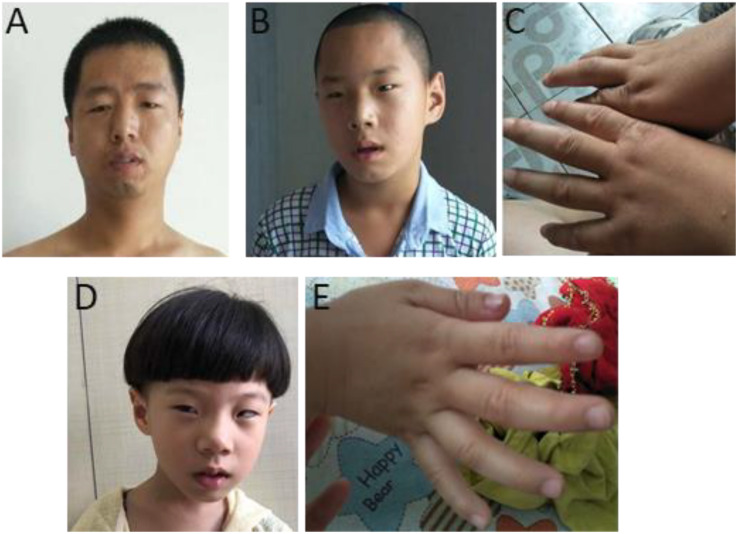
Photos of one family with 1q21.1 deletions (cases 7–9). (A) The father with mild dysmorphic facial features and the son with intellectual disabilities, strabismus, deformed ears (B), and tapered fingers (C). (D,E) The daughter has intellectual disabilities. Like her elder brother, she also manifested with strabismus, pointed chin and deformed ears (D), and tapered fingers (E).